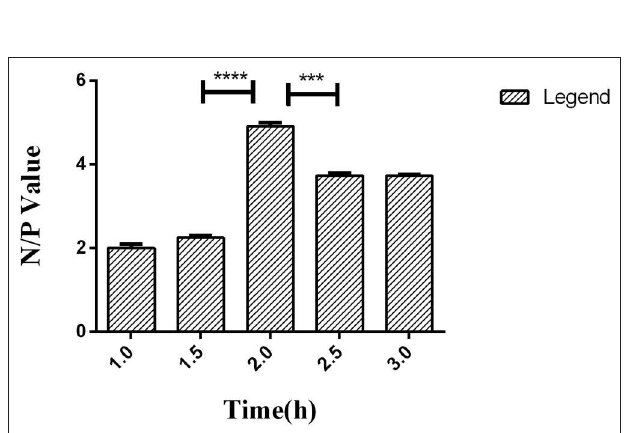
FIGURE 7 | Time effect of HRP-labeled O 9 McAb binding with coated LPS in